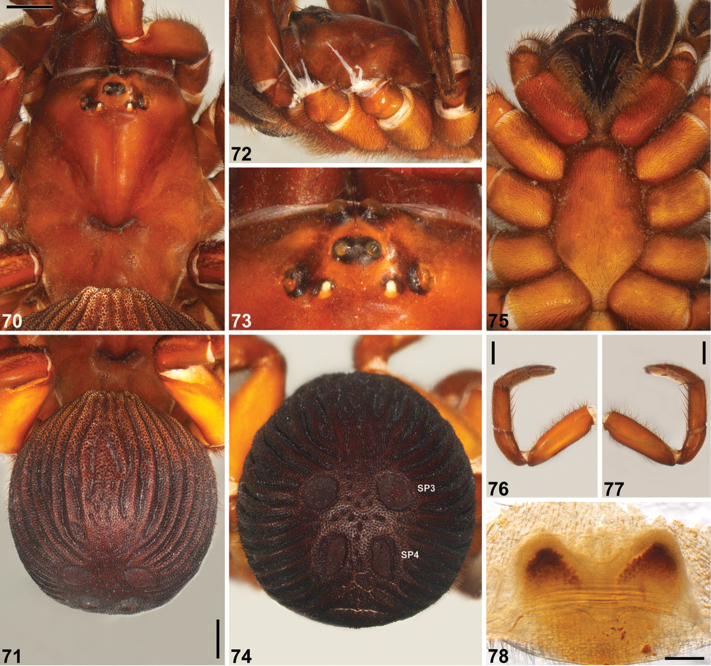

Idiosoma
arenaceum sp. n., female (AMS KS6393) from Geraldton (Western Australia; GES). 70–71 Carapace and abdomen, dorsal view 72 Carapace, lateral view 73 Eyes, dorsal view 74 Abdomen, posterior view 75 Sternum, ventral view 76 Leg I, prolateral view 77 Leg I, retrolateral view 78 Spermathecae, dorsal view. Scale bars 2.0 (70–71, 76–77), 0.5 (78). SP3–4 = sigilla pairs 3–4.